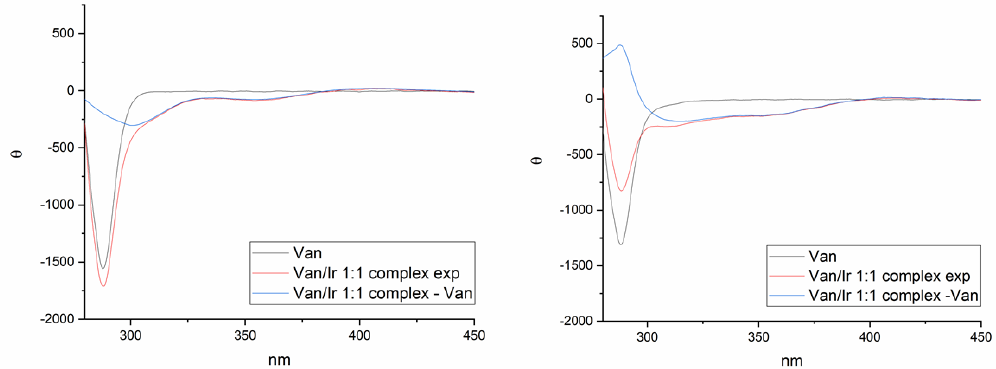
Figure 1. Circular dichroism (CD) spectra of free Vancomycin (Van) (black line) and Van/Ir 1:1 complex (red line) recorded in acetate buffer (pH 5, on the left ) and in phosphate buffer (pH 8, on the right ) are reported. The blue line is the obtained spectrum by subtracting Van contribution from the 1:1 complex. The concentration of Ir(III) is 2.5 mM.